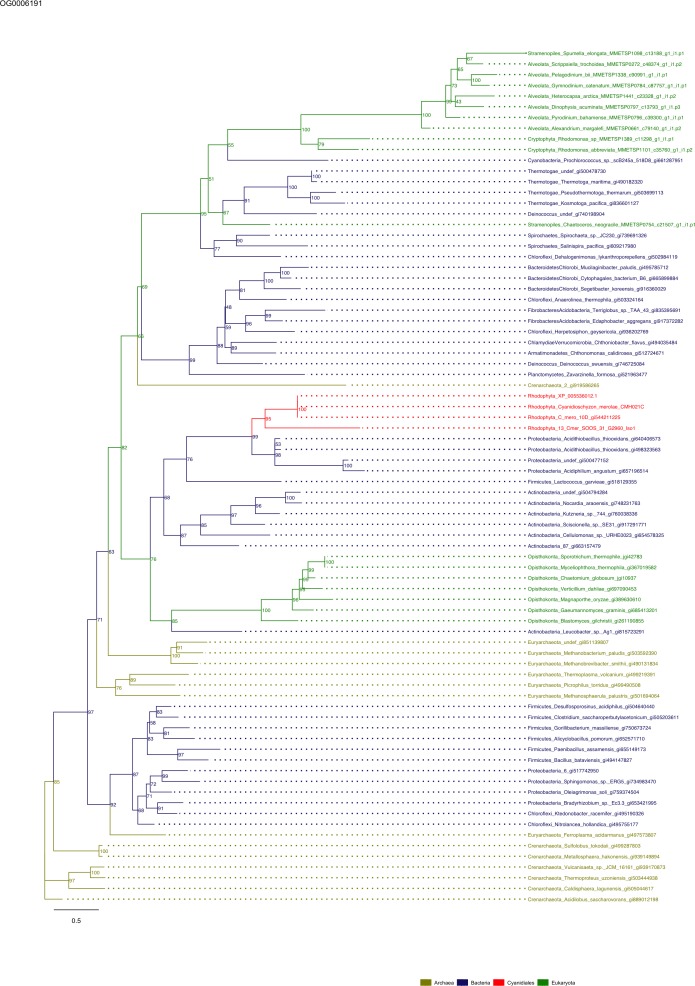
Sequence tree of orthogroup OG0006191.The tree is based on amino acid sequences. Archaea (yellow), Bacteria (blue), Cyanidiales (red), Eukaryotes including other red algae (green). Branches containing Cyanidiales sequences are highlited in red.